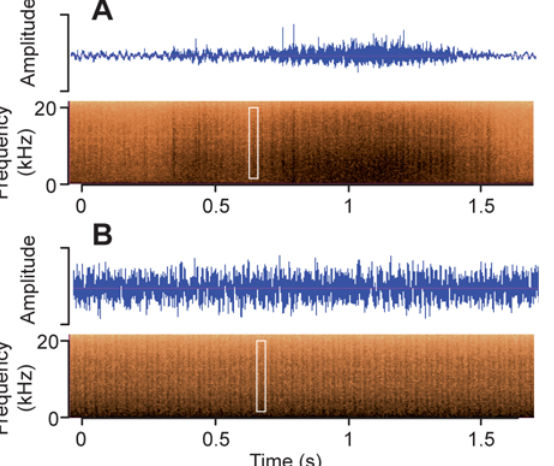
Fig 4. Train-rattling produces a broadband, pulsating sound. Each white box highlights a single rattle note. (A) Relative waveform amplitude (in arbitrary units) and spectrogram of the mechanical sound produced when a peacock performs the train-rattling display. The variation in intensity from 0 to 1 s is due to the peacock modulating the amplitude of his feather vibrations. (B) An array of tail feathers shaken at the train- rattling frequency in the laboratory produced a mechanical sound similar to that shown in